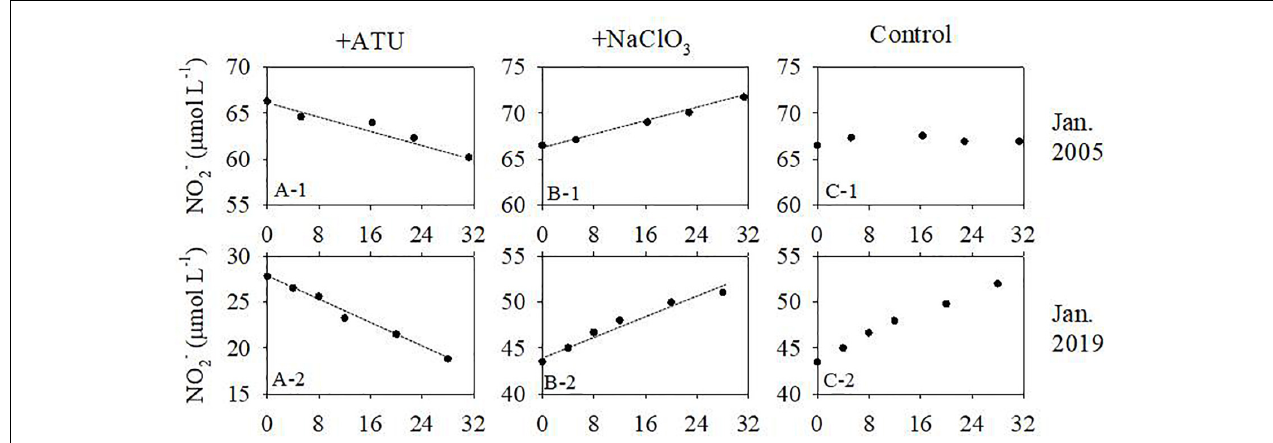
FIGURE 8 | Evolution of NO 2 - concentration during the nitrification incubations. The dashed lines are linear regressions. Data for January 2005 are from Dai et al. (2008). Labels are the same for all